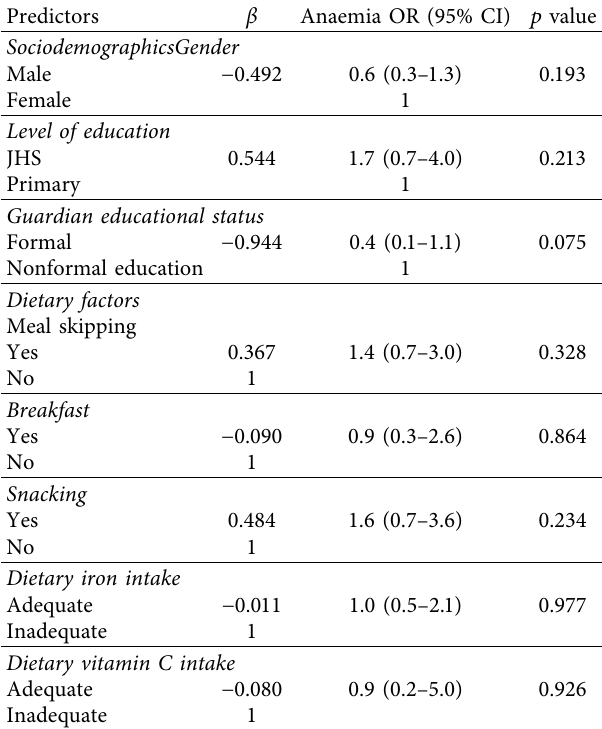
Table 5: Binary logistic regression for predictors of